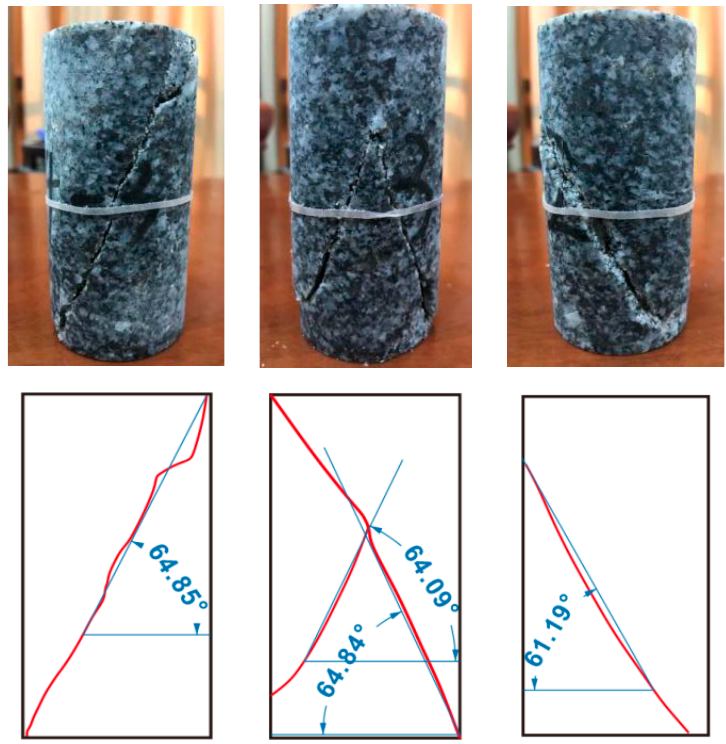
Figure 13. Test results and failure modes of granite with confining pressure at 20 MPa.